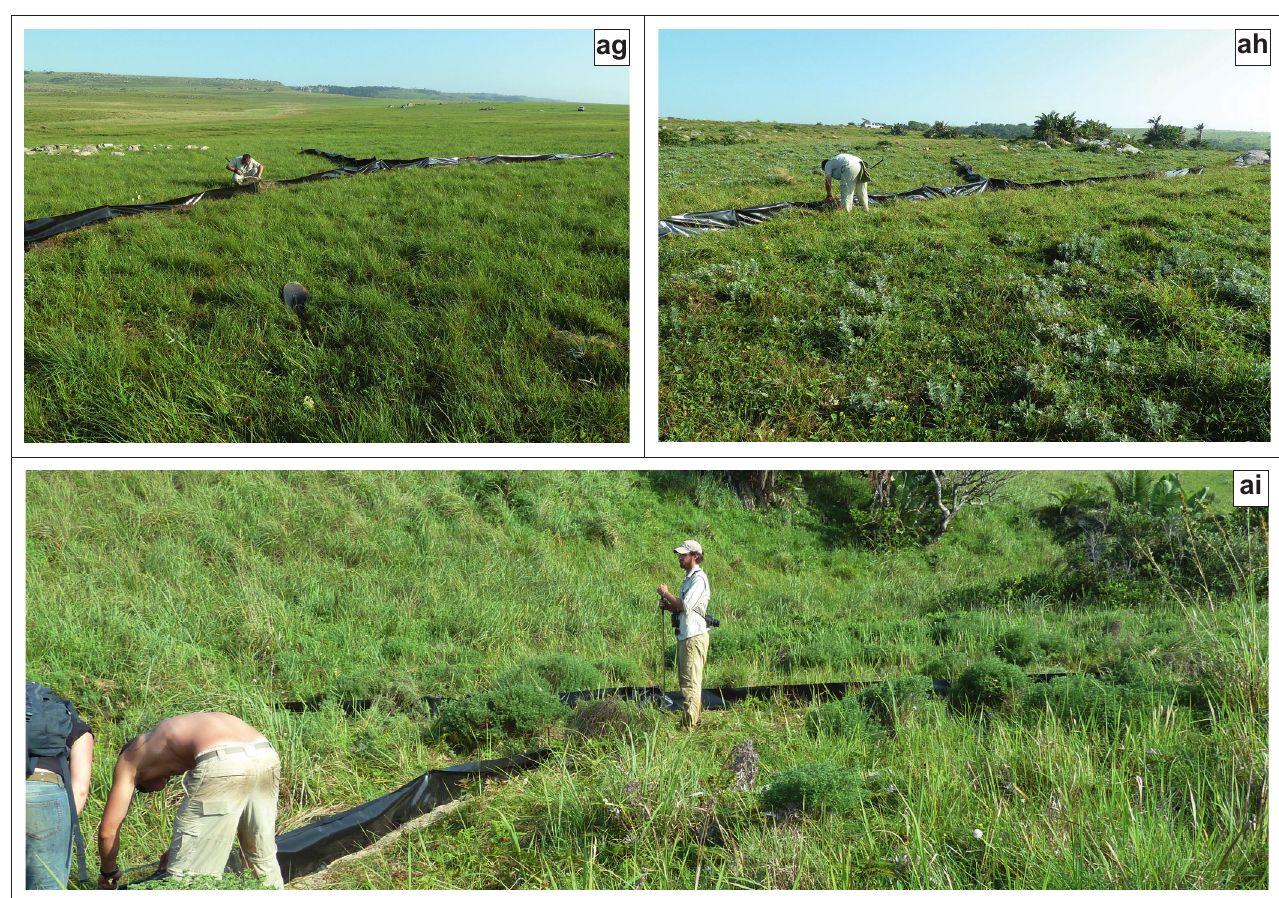
FIGURE 1-A4 (Continues...): (a–ai) Habitat type and trap layout of the respective trap sites surveyed during this